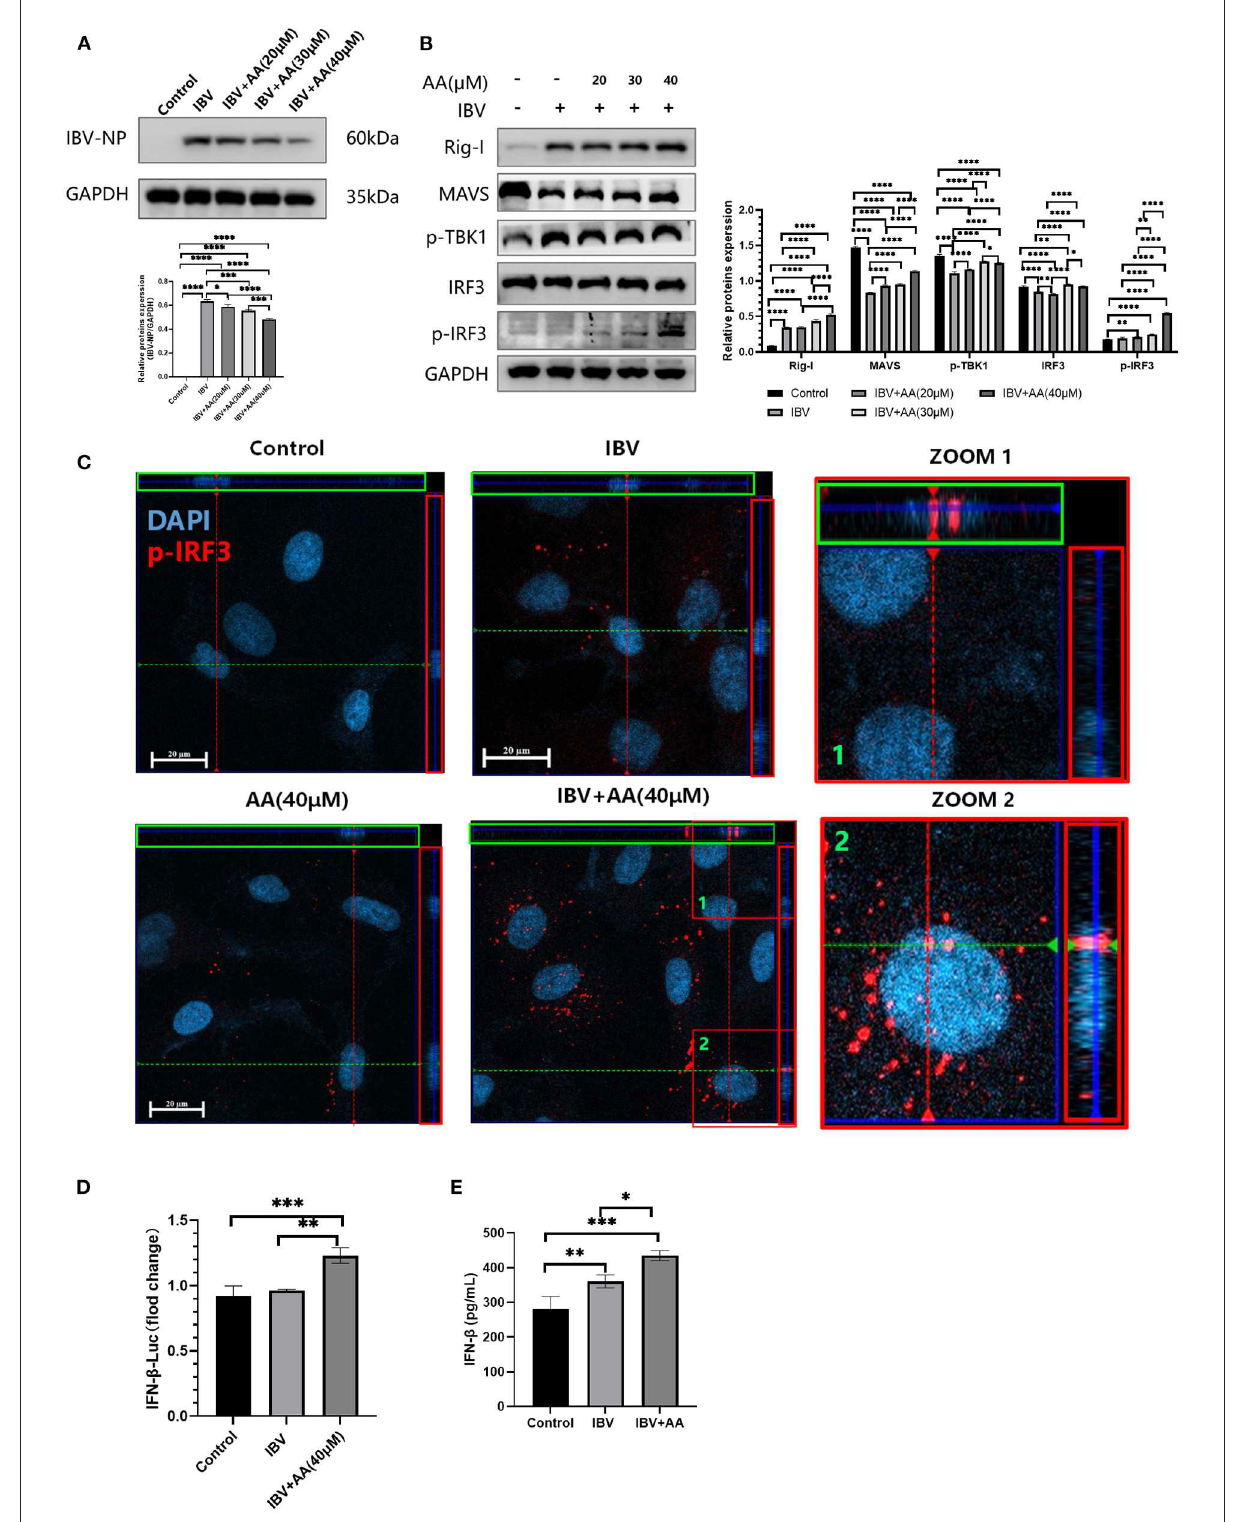
FIGURE3 Atractyloside A can increase levels of phosphorylation of IRF3 to inhibit IBV replication. (A) Western blot analysis of nucleoprotein expression after IBV infection in Atractyloside A treatment groups with different drug concentrations. (B) Western blot analysis of RIG-I pathway proteins after IBV infection in Atractyloside A treatment groups with different drug concentrations. (C) Laser confocal observation of p -IRF3 expression after IBV infection in the different groups. (D) IFN β luciferase activity was analyzed after IBV infection in the different groups. (E) Levels of IFN- β in the serum. The results are presented as mean ± standard deviation (* p < 0.05, ** p < 0.01, *** p < 0.001, and **** p <